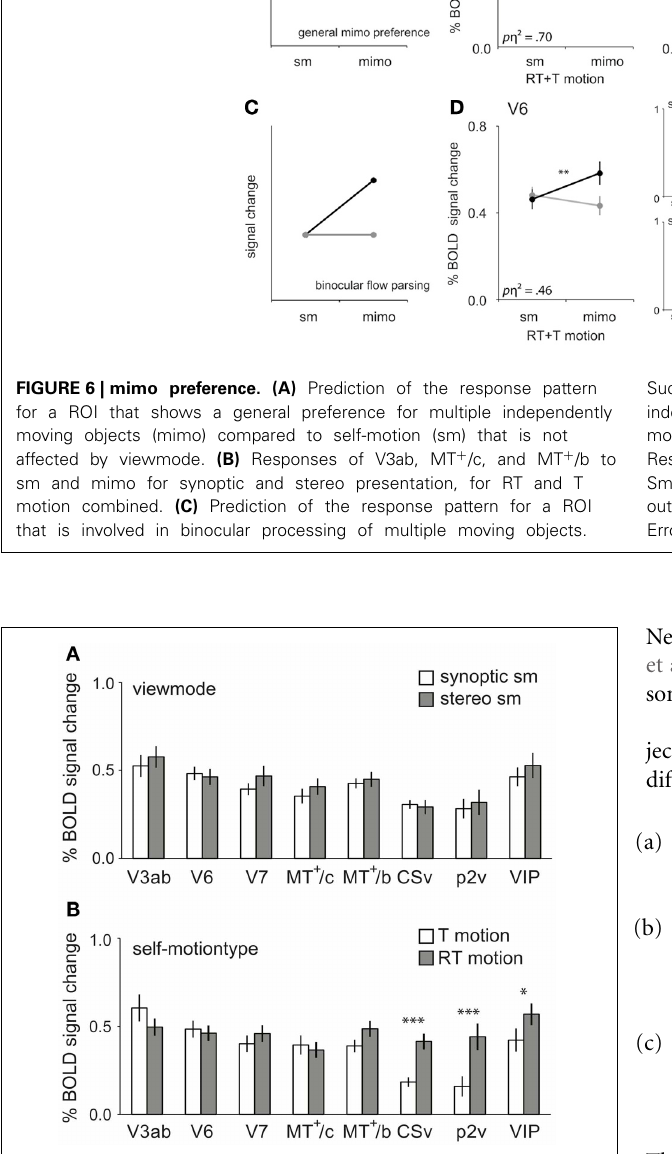
FIGURE 7 | Main effects of self-motion type and viewmode across subjects. (A) The averaged BOLD response within the ROIs at different levels of viewmode (synoptic, stereo, only sm) and self-motion type (RT motion and T motion, sm data). No ROI showed a larger response to stereo presentation than to synoptic presentation of the stimuli. (B) The averaged BOLD response within the ROIs for sm at different levels of self-motion type (T motion, RT motion), pooled over viewmode (synoptic, stereo). CSv, p2v, and VIP showed a significantly larger response to motion with a strong rotational component ( ∗ p < 0 . 05, ∗∗∗ p < 0 . 001, p η 2 = 0 . 69; 0.70; 0.39). Error bars represent